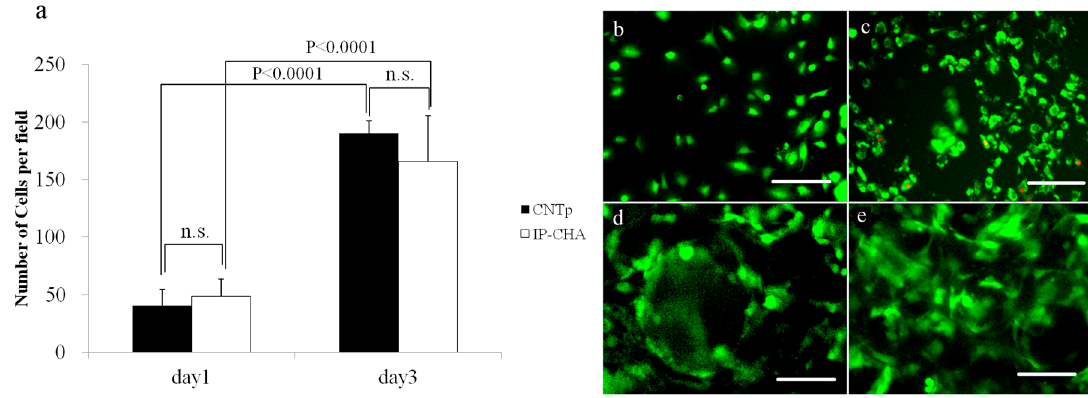
Figure 8. Cytotoxicity. Graph shows the number of cells per field counted on the surface of the CNTp and the IP-CHA ( a ). Mean values were compared using Student’s t test ( n = 7). N.S.: Not Significant. Viable cells were stained with calcein AM (acetoxymethyl) and fluoresced green, while dead cells were stained with EthD-III and fluoresced red. Most of MC3T3-E1 cells were alive on CNTp ( b , c ) and IP-CHA ( d , e ) scaffolds at day 1 ( b , d ) and day 3 ( c , f ). White bars: 100 µ